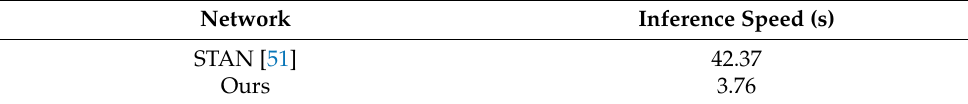
Table 11. Comparisons of the inference speed on REDS4.